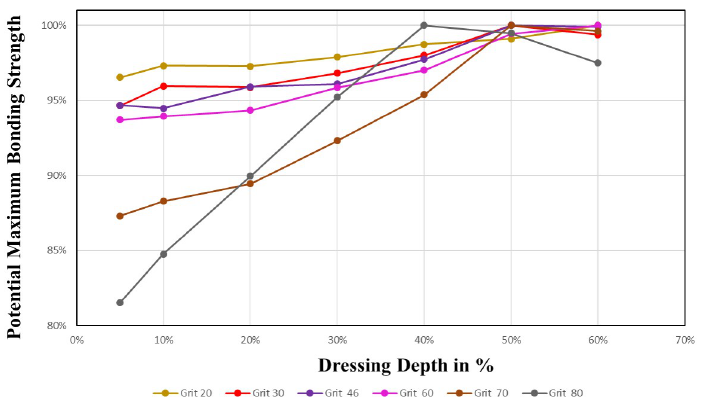
Figure 31. Potential maximum of bonding strength dependent on the percentual dressing